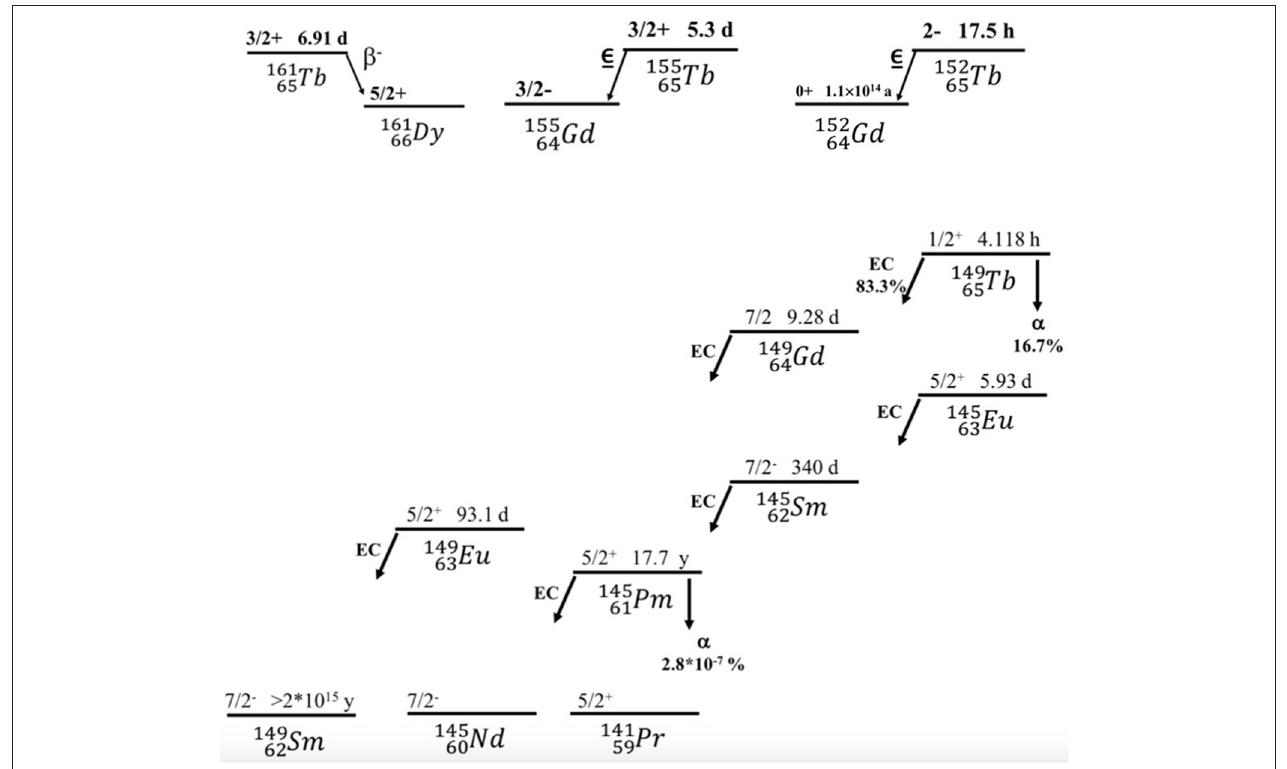
FIGURE 2 | Decay series of Tb ( 161 Tb, 155 Tb, 152 Tb, 149 Tb)